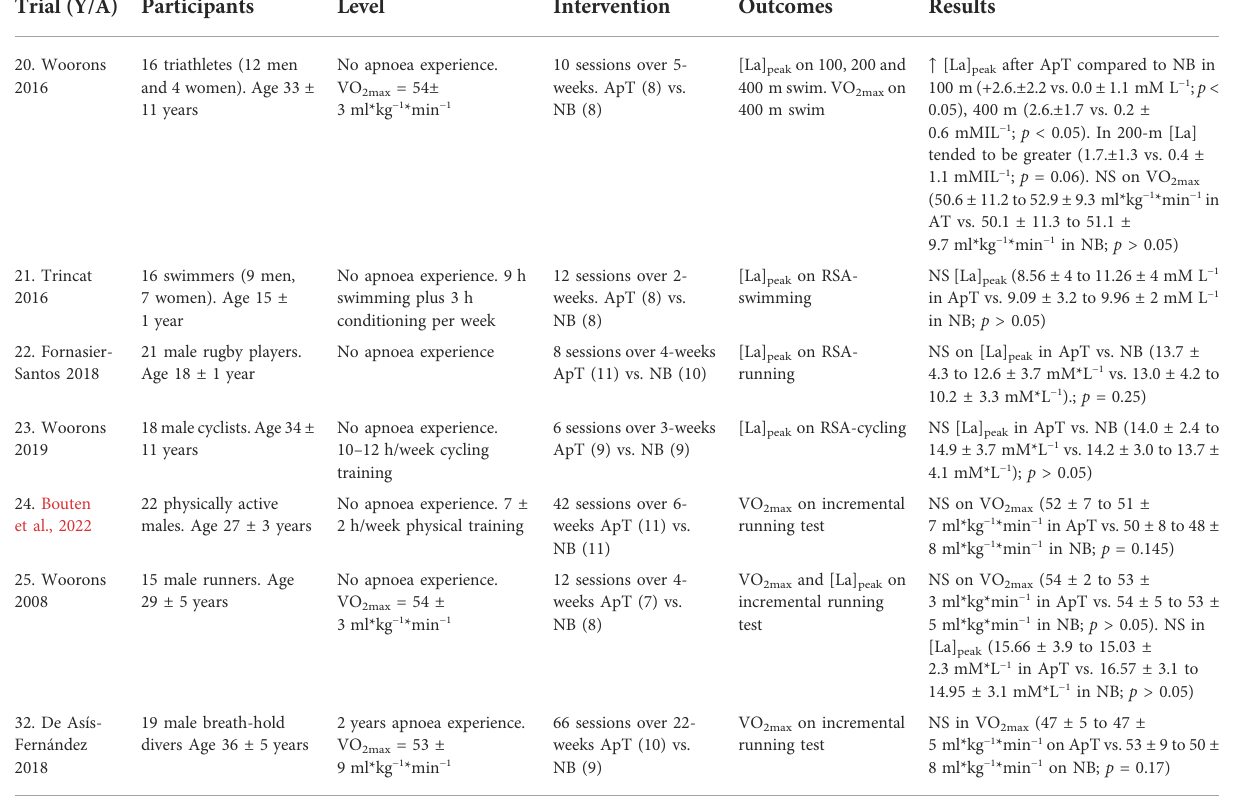
TABLE 2 Characteristics of apnoea training (AT) and normal breathing (NB) of included studies. [La] peak peak blood lactate concentration, VO 2max maximal aerobic capacity, NS not statistically signi fi